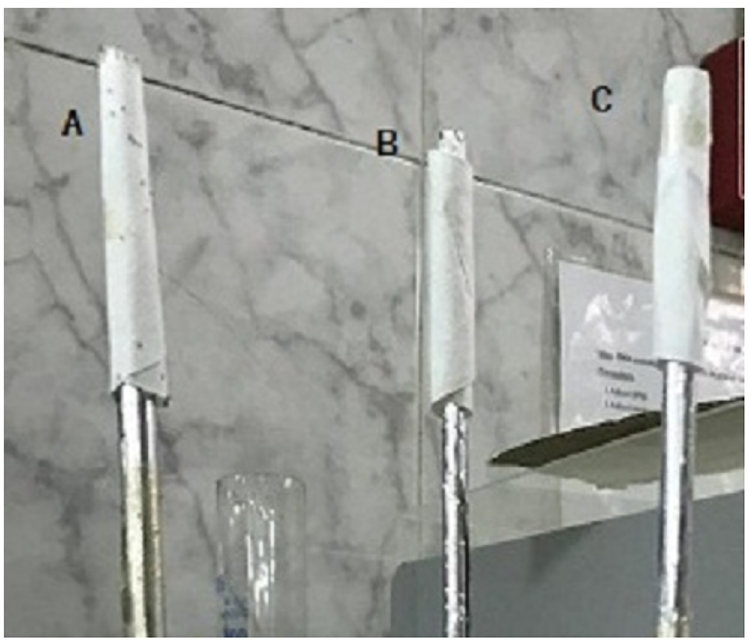
Fig 4. Repellency technique (Road vertical method) at the first hour post application: A. Control negative ethyl alcohol 70% showed tick larvae at the top of the filter paper, B. Trans-anethole treated filter paper with no larvae at the top. C. Control positive treated filter paper by DEET showed no larvae at the top.